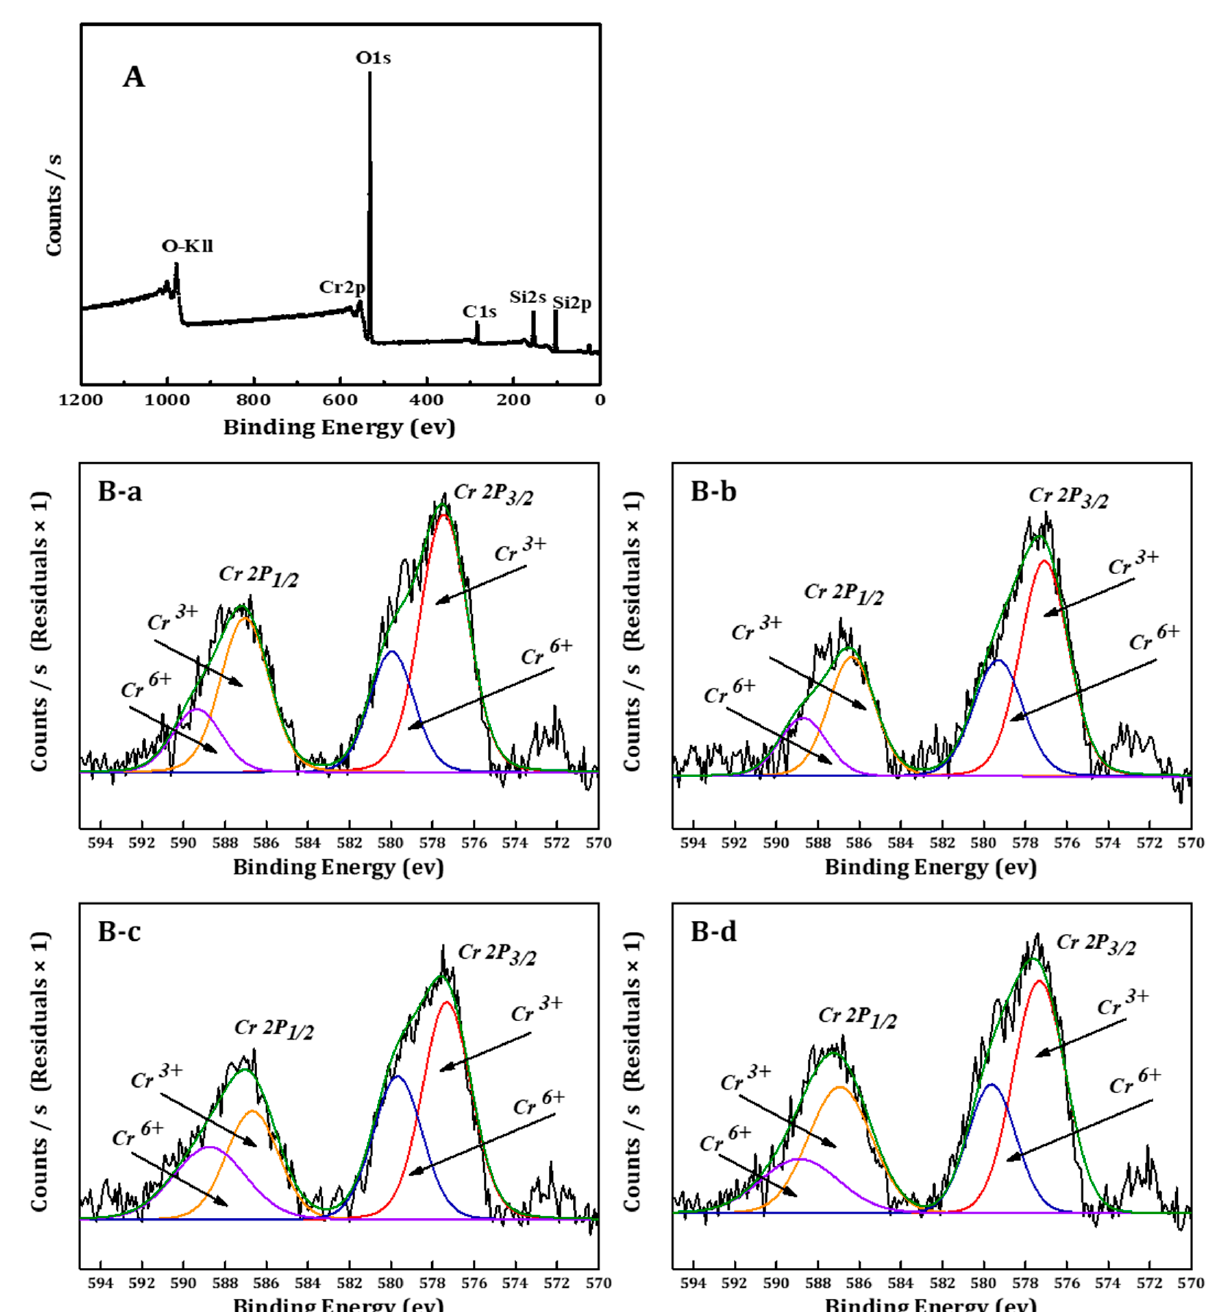
Figure 4. ( A ) XPS survey scan of Cr(8)/MOS; ( B ) Cr2p XPS spectra of Cr(x)/MOS, formed with varying Cr loading, where x: ( B ‐ a ) 2, ( B ‐ b ) 5, ( B ‐ c ) 8, and ( B ‐ d ) 11 wt.% Cr.